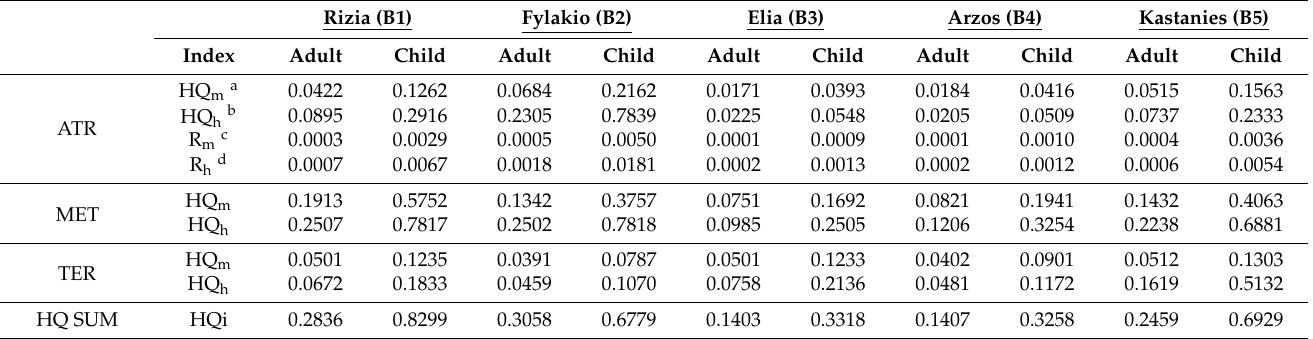
Table 6. HQ and R indexes of pesticides through drinking water consumption, pumped by drinking